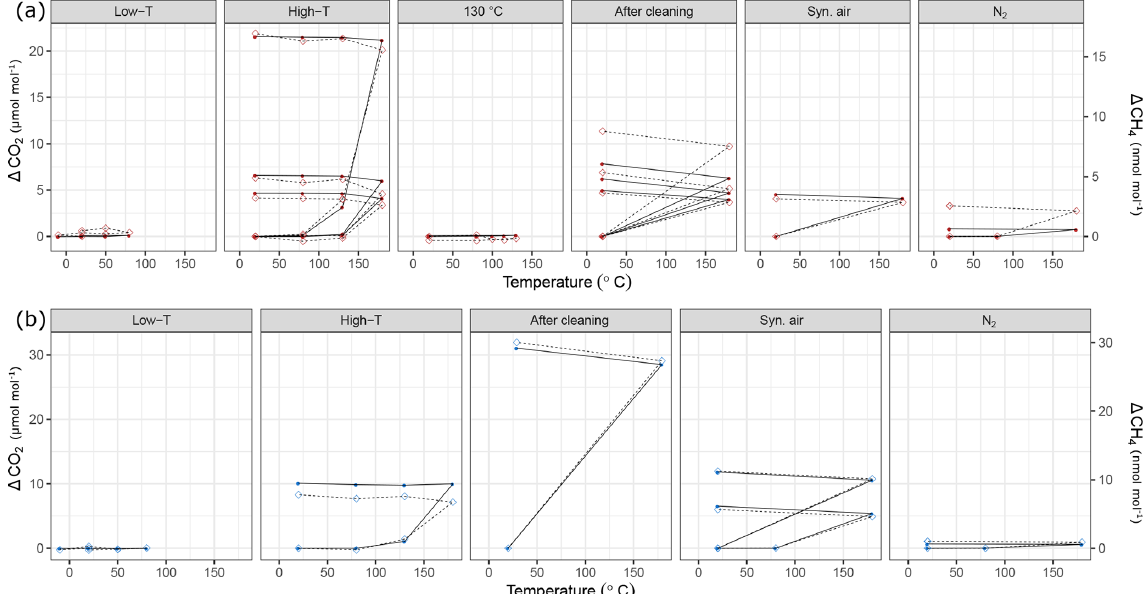
Figure 9. Temperature experiments using (a) steel (red) and (b) aluminum (blue) cylinder in chronological order for species CO 2 and CH 4 . Filled circles correspond to the left y axis (CO 2 ), whereas open diamonds correspond to the right y axis (CH 4 ). See Table 1 for details of the temperature cycles. In each subplot temperature cycles are connected with solid lines for CO 2 and with dashed lines for CH 4 . The y axes quantify the differences from the amount fractions measured at 20 ◦ C ( (cid:49) CO 2 and (cid:49) CH 4